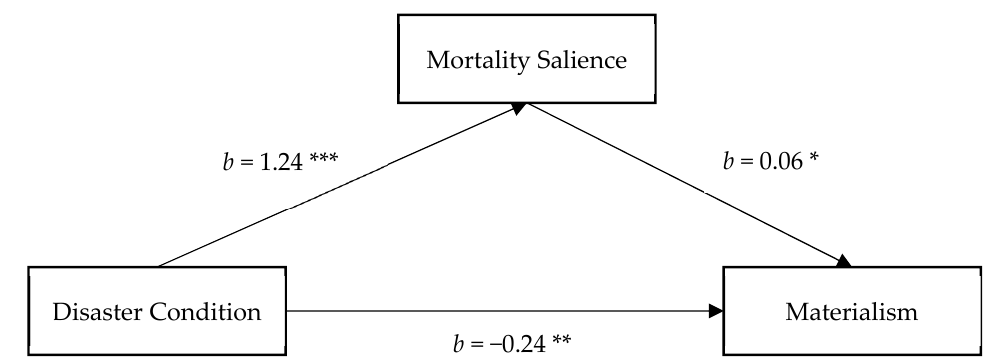
Figure 1. Mortality salience as a mediator of the relationship between the condition and materialism. Note: Reported values are unstandardized regression coefficients and standardized indirect effects with bootstrapped 95% confidence interval, *** p < 0.001, ** p < 0.01, * p < 0.05.